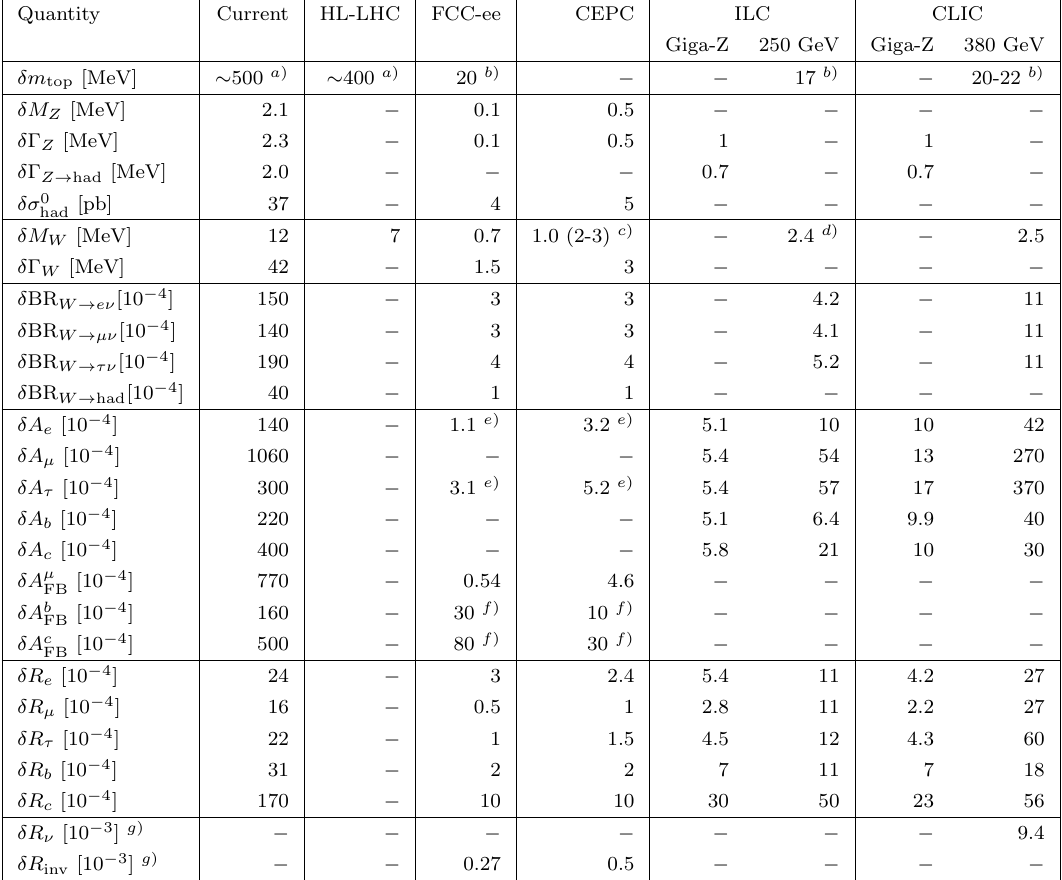
Table 27 . Uncertainty on several observables related to the properties of the electroweak vector bosons. We also list the uncertainty on the top mass. For dimensionful quantities the absolute uncertainty is given, while relative errors are listed for dimensionless quantities. A few comments on some particular numbers are in order: a) For hadron colliders the top mass is not the